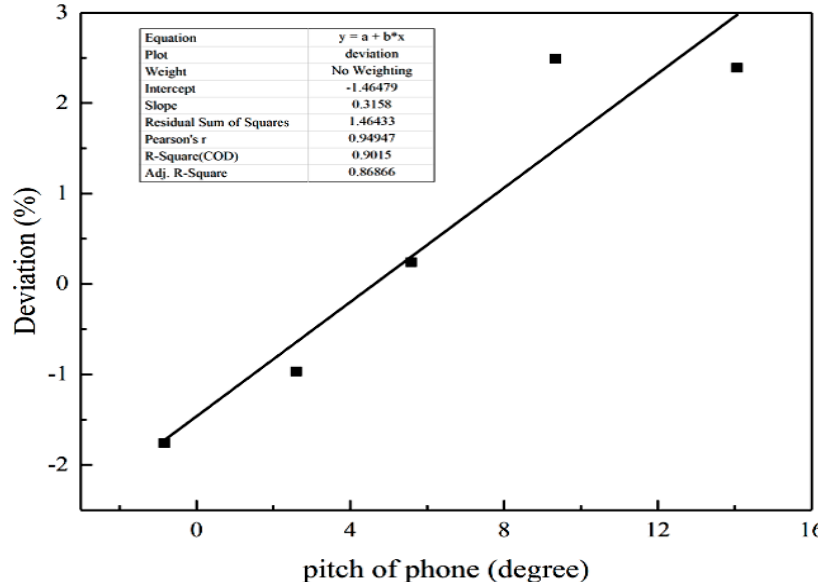
Figure 5. Measurement deviation at the different pitch of phone.